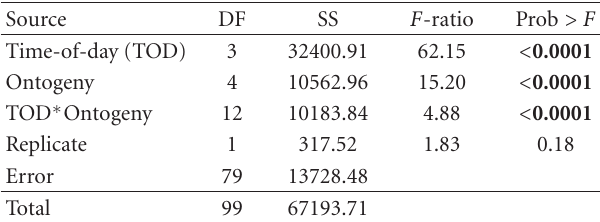
Table 1: Two-way ANOVA testing for e ff ect of time-of-day and ontogeny on Kelletia kelletii demersal behavior. DF: degrees of freedom, SS: sum of squares, replicate was treated as random. Bold results indicate